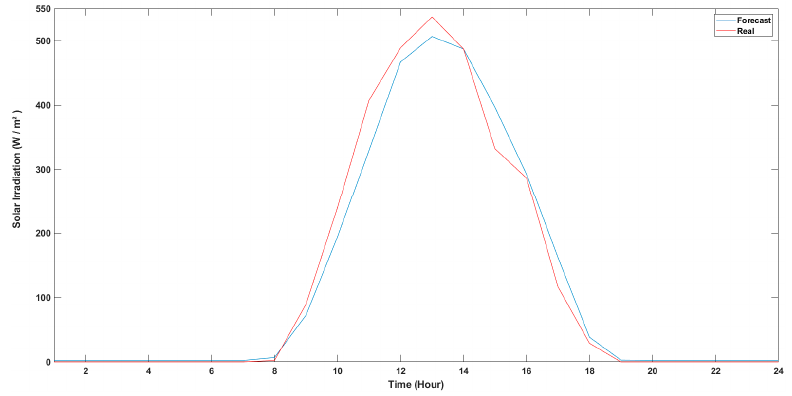
Figure 10. Forecasting and real solar irradiation curves for 04/02/2019. Table 8. Statistical performance measures for solar irradiation.